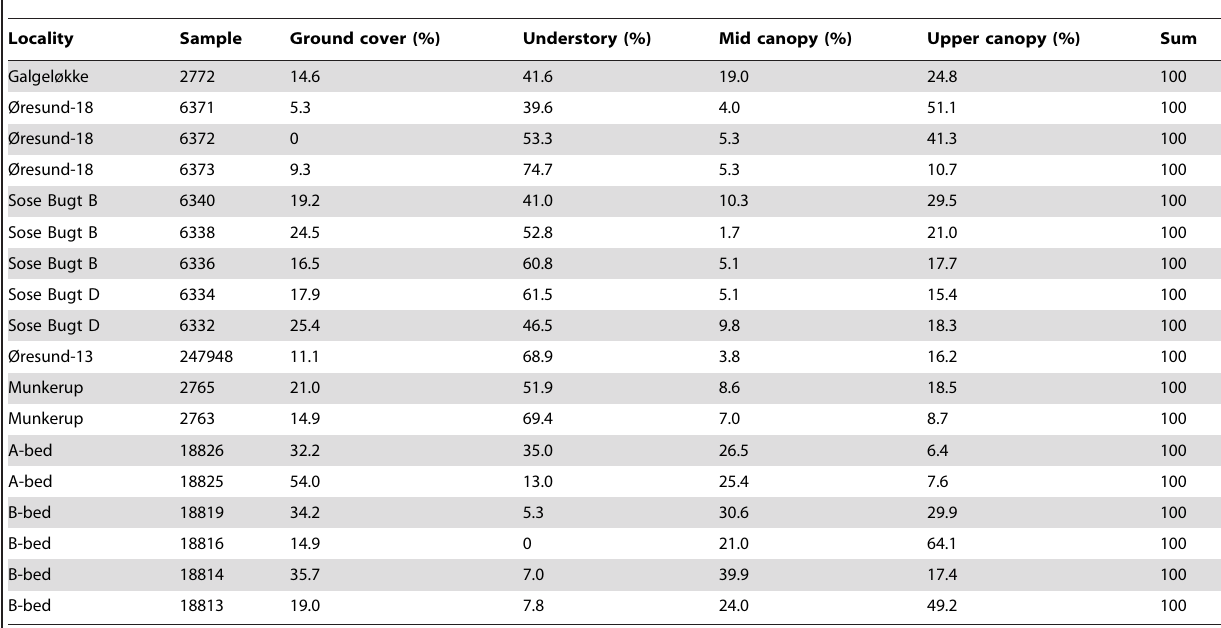
Table 3. Mire floral composition of the coal/coaly beds from the Danish Basin.